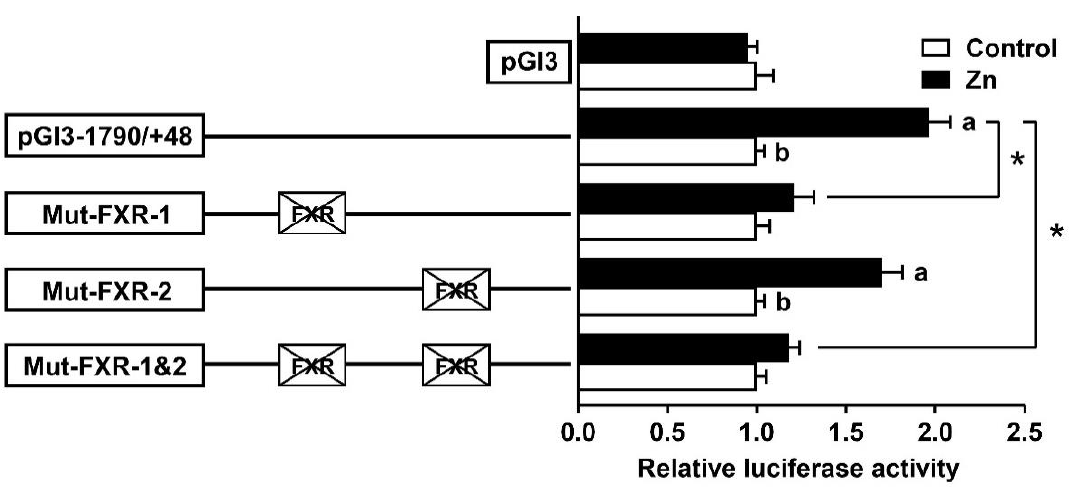
Figure 4. Assays of predicted FXR binding sites after site-directed mutagenesis. Values mean the ratio of activities of firefly to Renilla luciferase normalized to the control. Results are presented as mean ± SEM ( n = 3). Asterisk (*) indicates significant differences between the different mutation plasmids under the same treatment ( p < 0.05). Different letters indicate significant differences between different treatments in the same plasmid ( p <